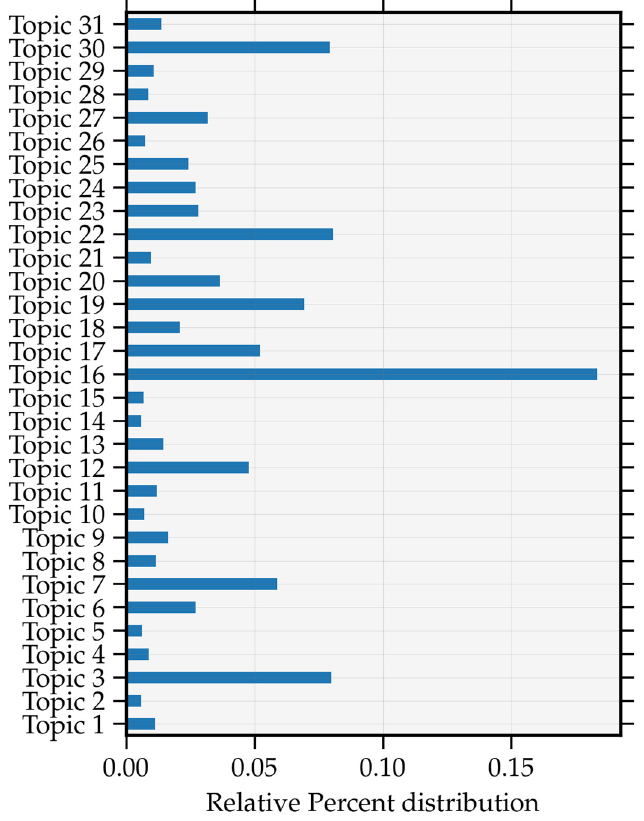
Figure 3. Distribution of topics across publications, 1990–2020.